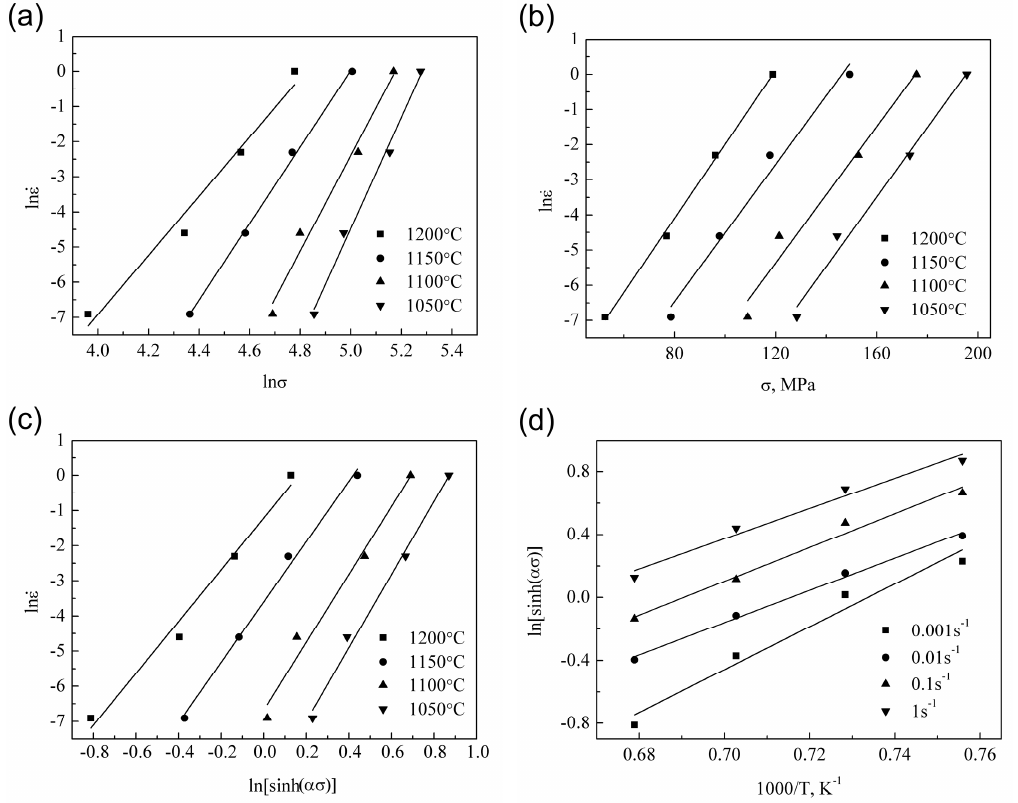
ε  . . ε vs. ln σ ; ( b ) ln ε vs ln σ ; ( b )